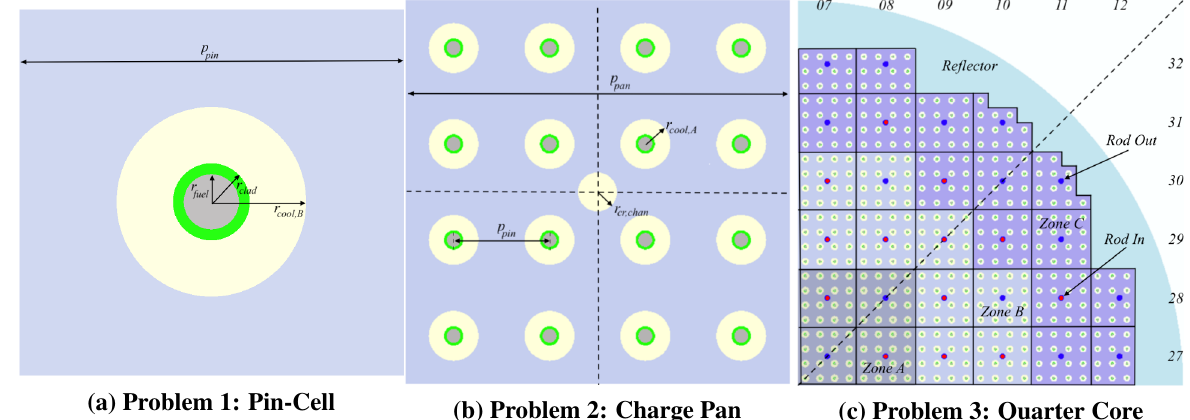
Figure 1: Magnox progression problem